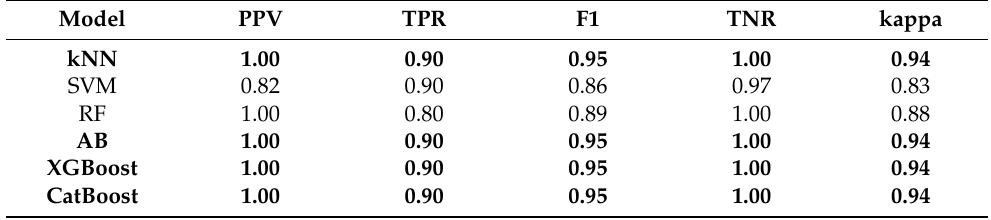
Table 3. Classifier_A results.